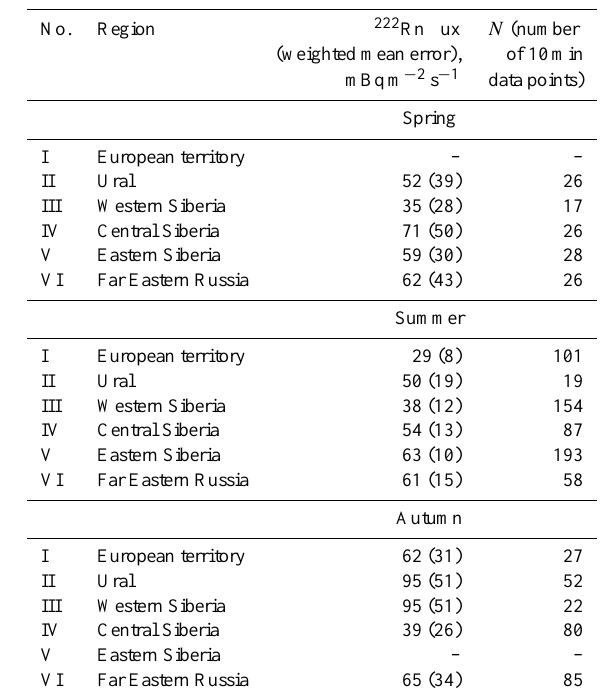
Fig. 5. Nocturnal 222 Rn flux calculation in stable atmospheric conditions at the route part 1256–1076km from Vladivostok to Moscow (the East European region) 10 July 2001, 02:54–06:10 LT (the TROICA-7 expedition). Slope defines 222 Rn flux in this region. Glazov is the largest locality on the presented